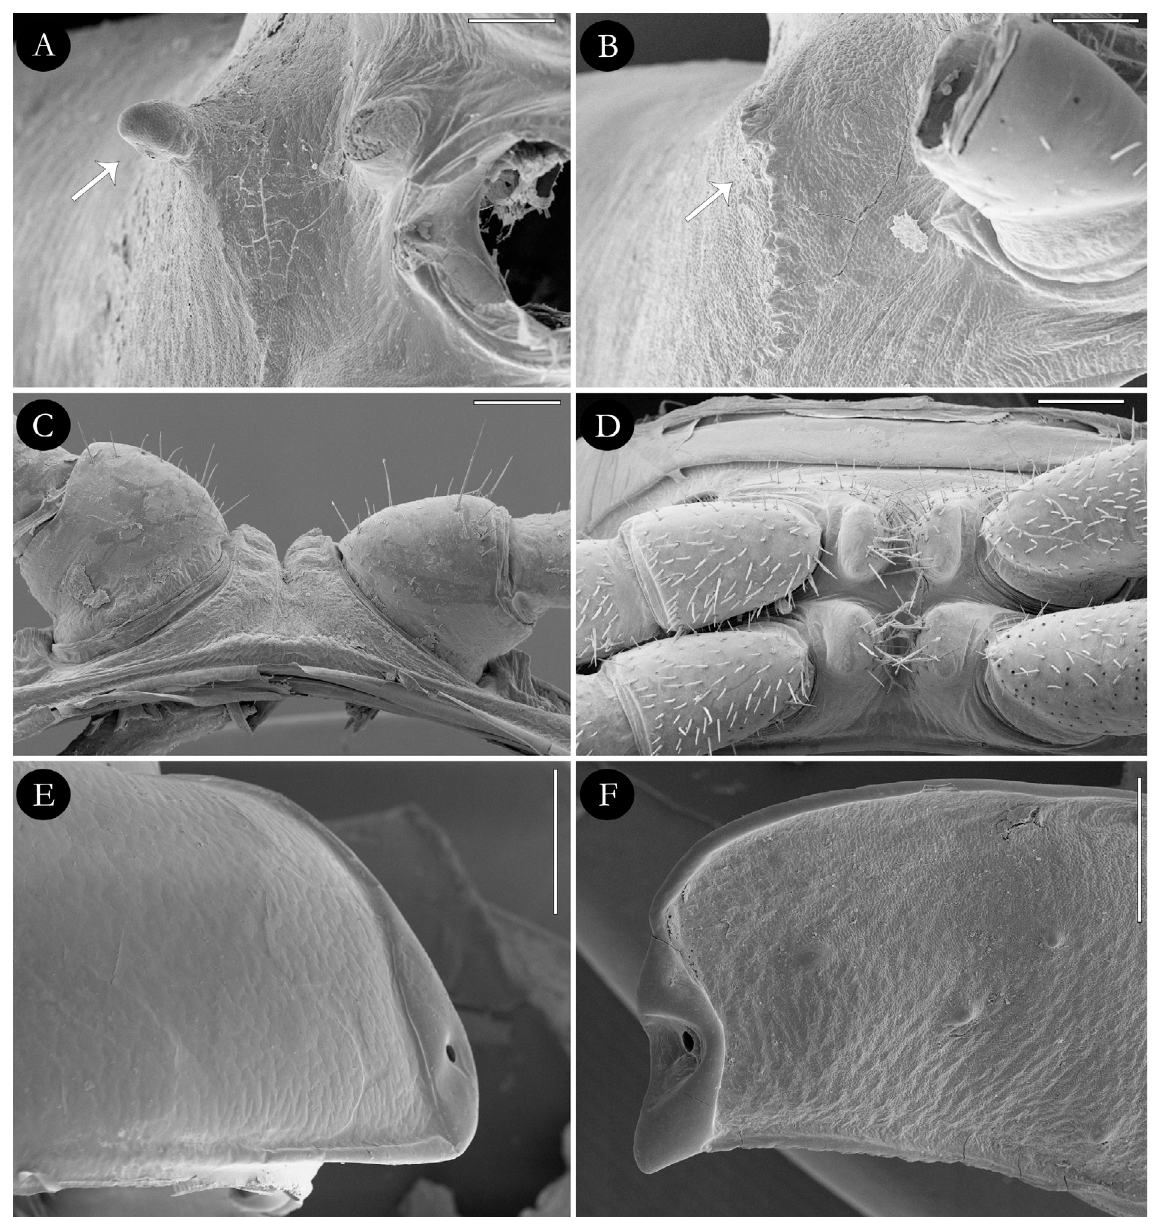
Fig. 5. A–B . Lateral projection on the seventh sternite. A . Smooth in Atlantodesmus eimeri (Attems, 1898). B . Serrated in A. pintoi (Schubart, 1946). C . Ventral projection on the fourth sternite in A. teresa (Hoffman, 2000). D . Ventral projection on the fifth sternite in Arthrosolaenomeris pantalanensis Schubart, 1943. E–F . Shape of the posterior edge of the paranota. E . Rounded in A. pantalanensis . F . Acuminate in Atlantodesmus eimeri (Attems, 1898). Scale bars: A–B = 250 µm; C–F = 500